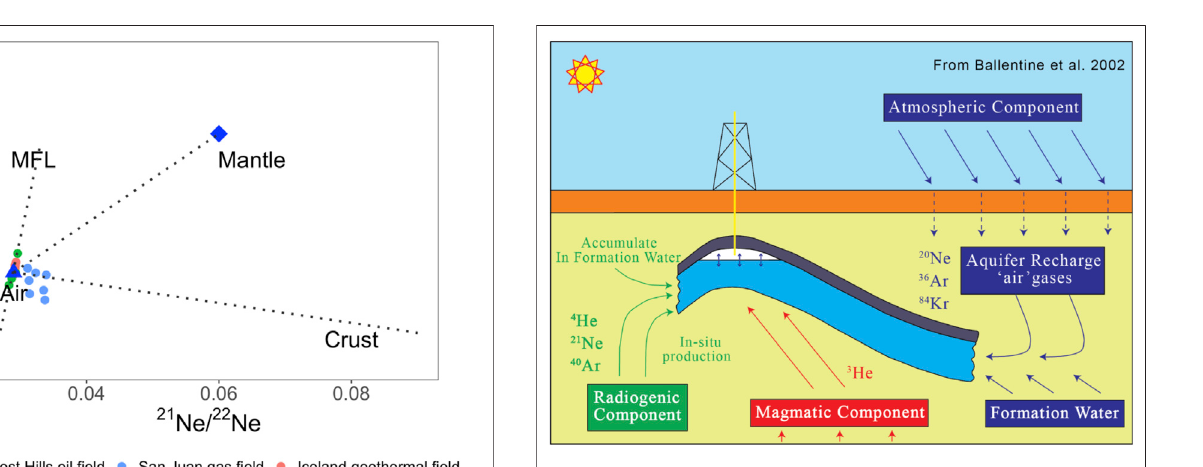
FIGURE 4 | A schematic conceptual model showing three distinct sources of noble gas isotopes modi fi ed in hydrocarbon systems, redrawn from Ballentine et al.